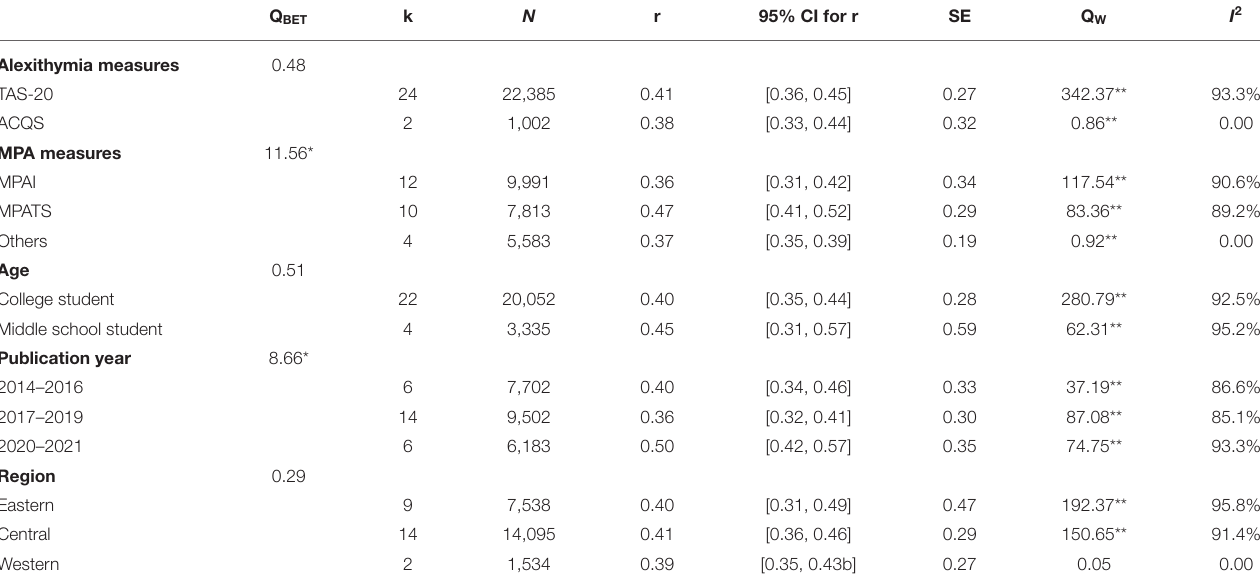
TABLE 3 | Alexithymia and MPA: univariate analysis of variance for moderator